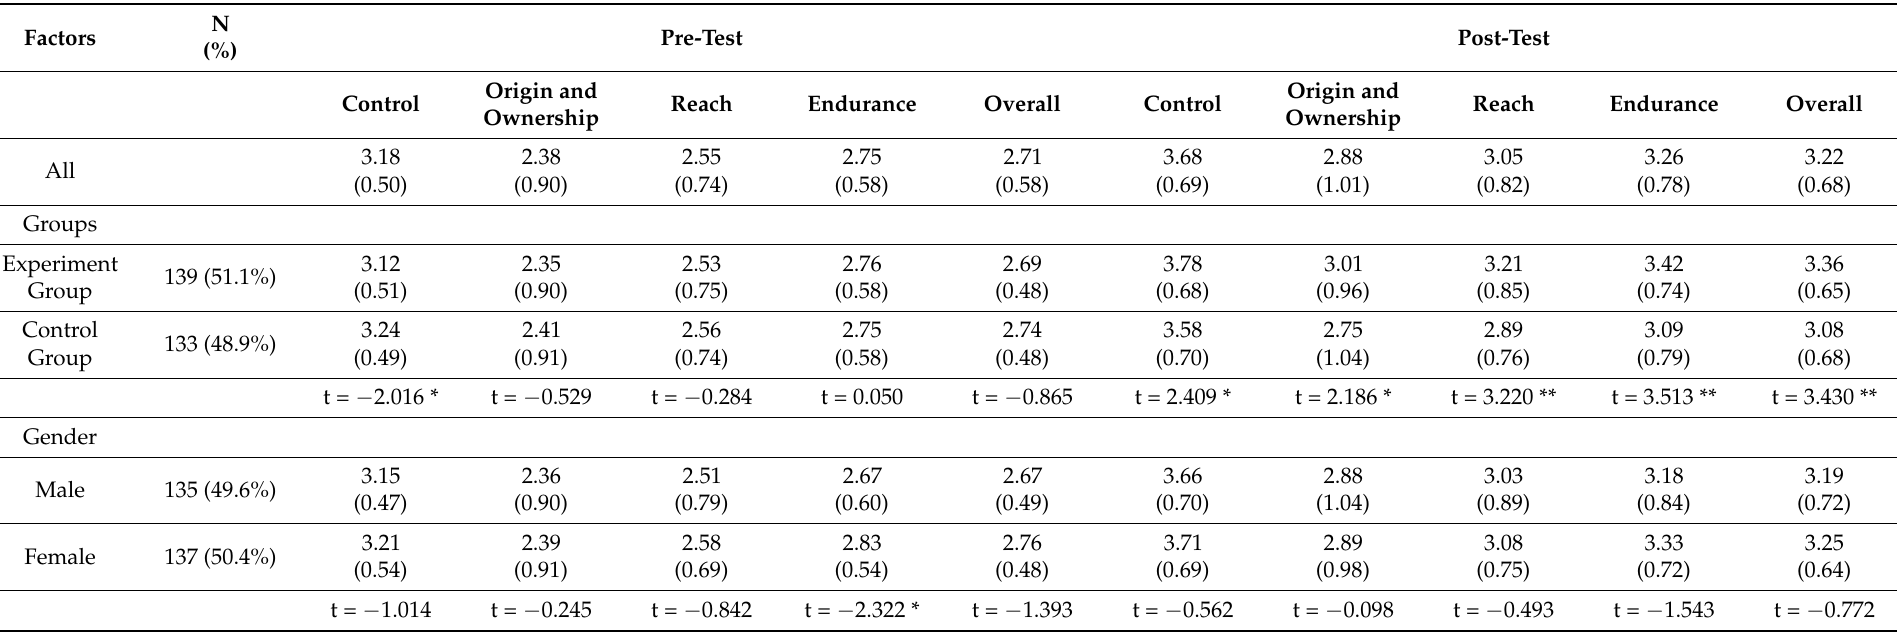
Table 2. Descriptive Statistics: Participants’ Demographics and their Relationship with the Adversity Response Profile